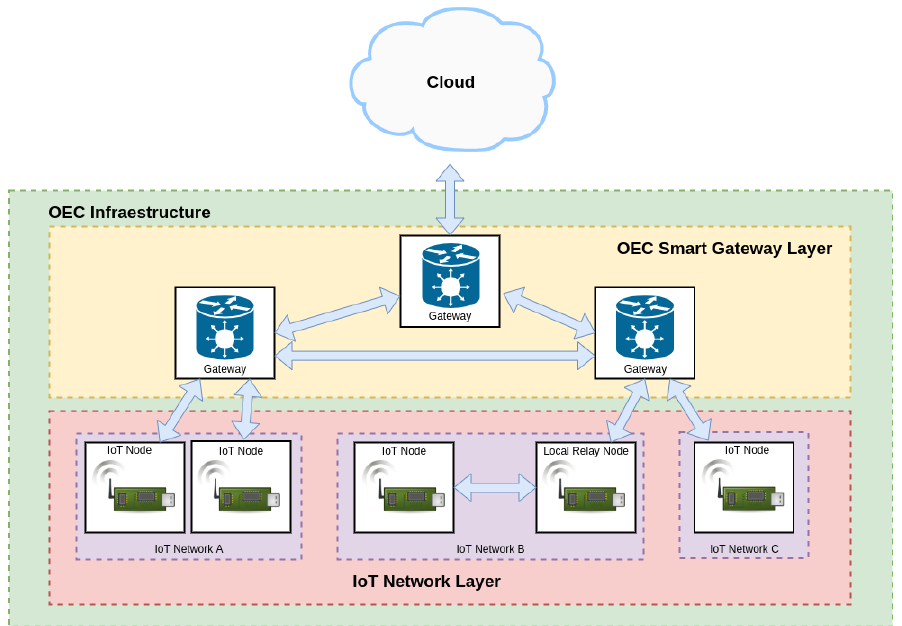
Figure 2. Proposed OEC communications architecture.